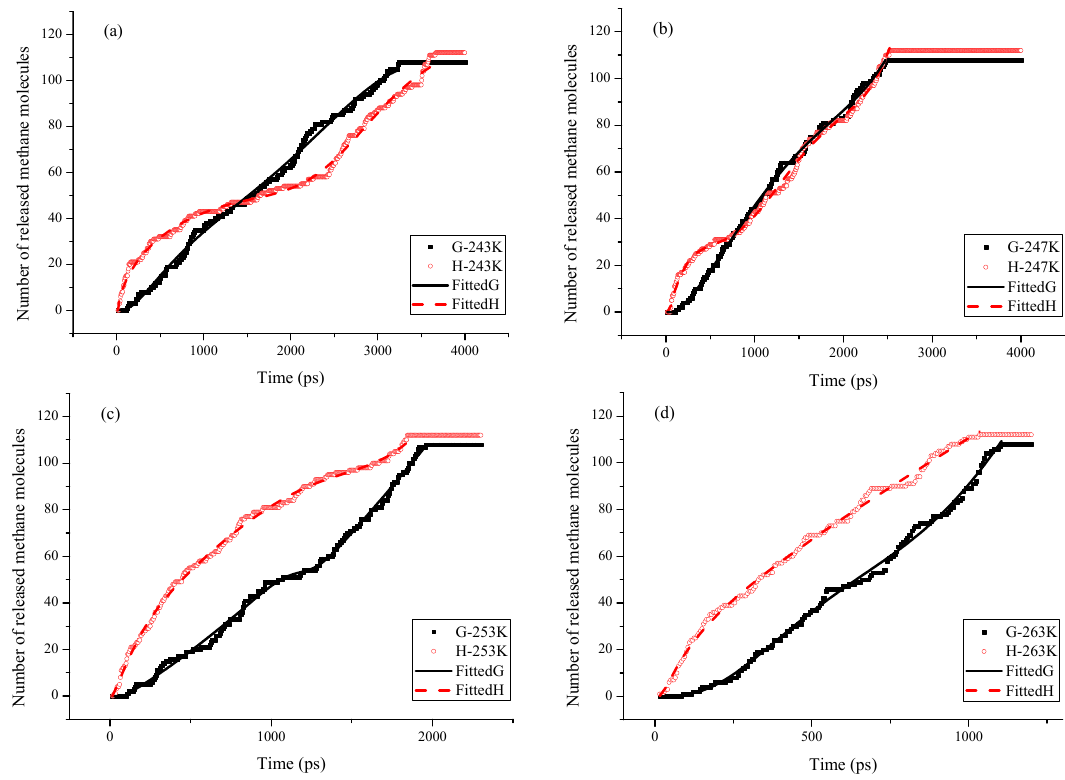
Figure 5. The number of CH 4 molecules released from liquid and gas side in various simulation temperature. ( a ) in 243 K, ( b ) in 247 K, ( c ) in 253 K, ( d ) in 263 K.